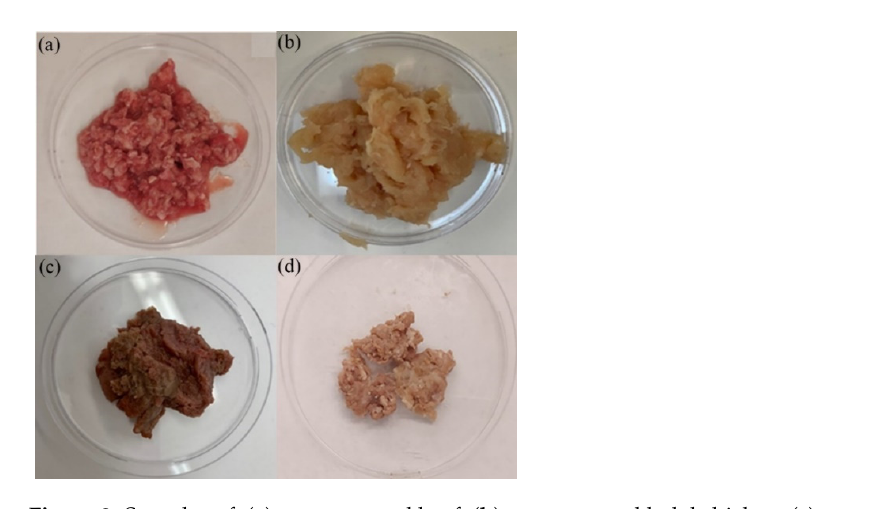
Figure 2. Samples of; ( a ): unprocessed beef; ( b ): unprocessed halal chicken; ( c ): unprocessed halal beef; ( d ): SC-CO 2 -processed beef under pressure at 3.04 × 10 7 Pa and a temperature of 50 ± 5 ℃ .